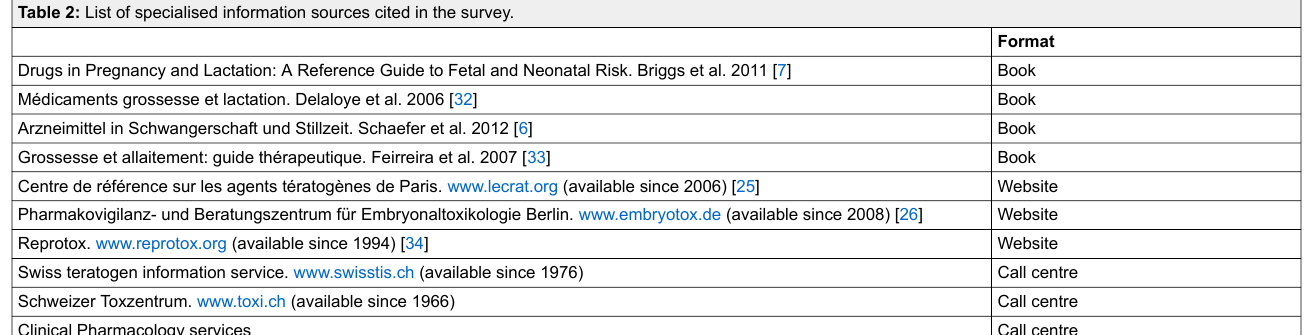
Table 2: List of specialised information sources cited in the